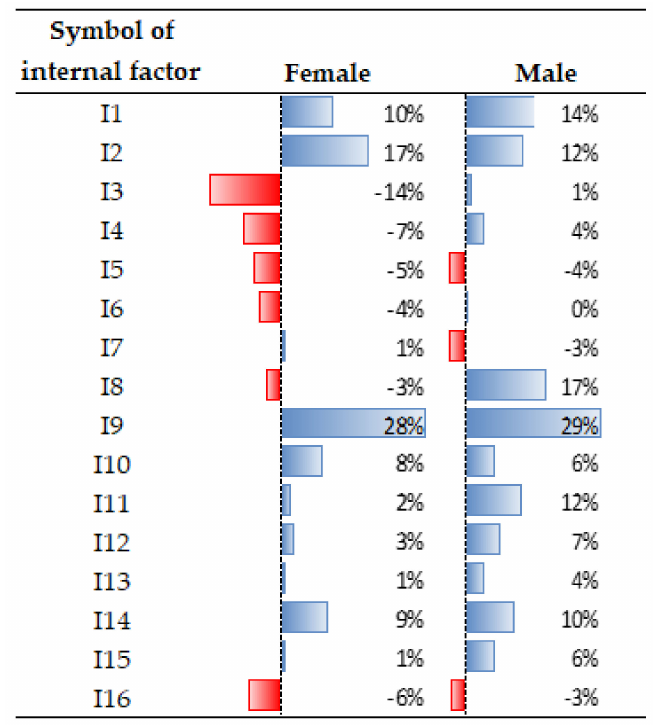
Figure 8. Differences in the perception of internal factors, broken down by gender. Source: own study.